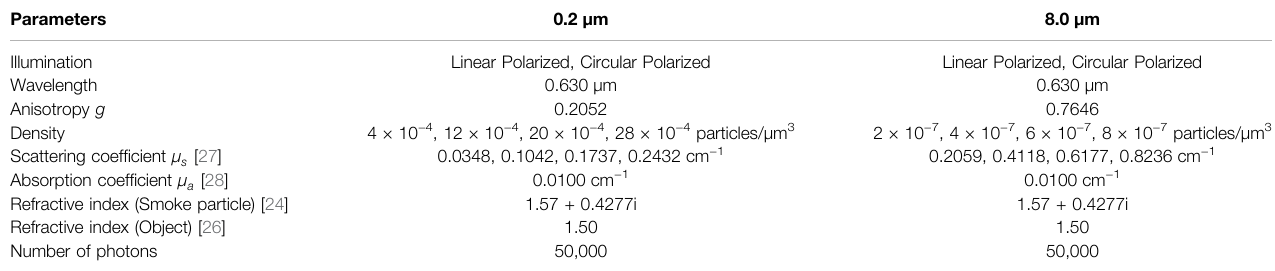
TABLE 1 | Simulation parameters of medium with different